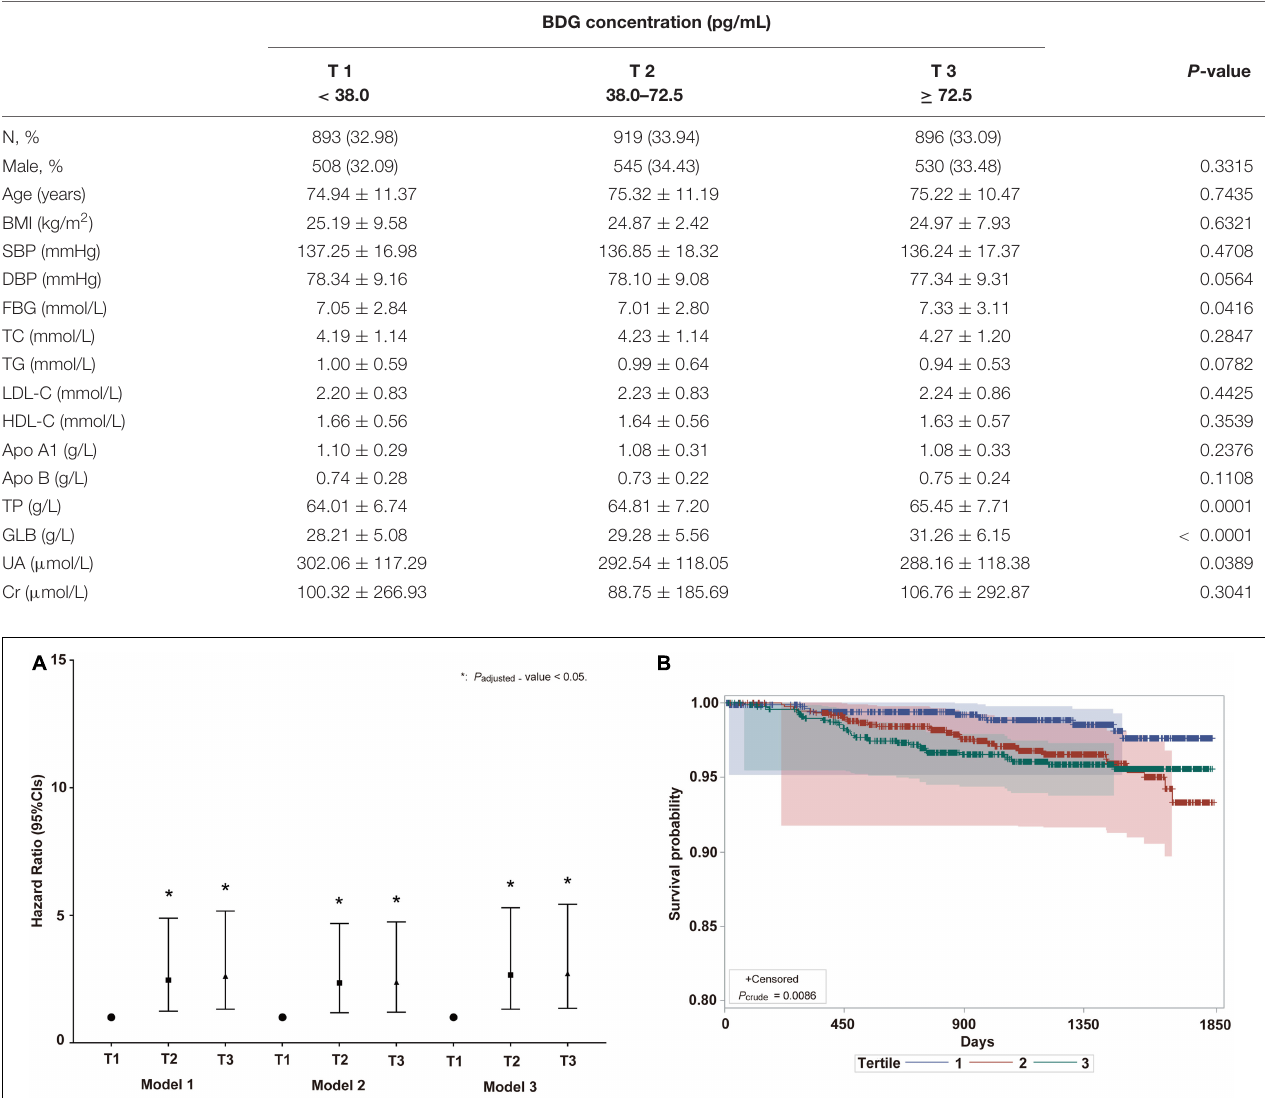
TABLE 2 | Characteristics of participants according to β -D-Glucan (BDG) concentration at baseline in the prospective cohort study.